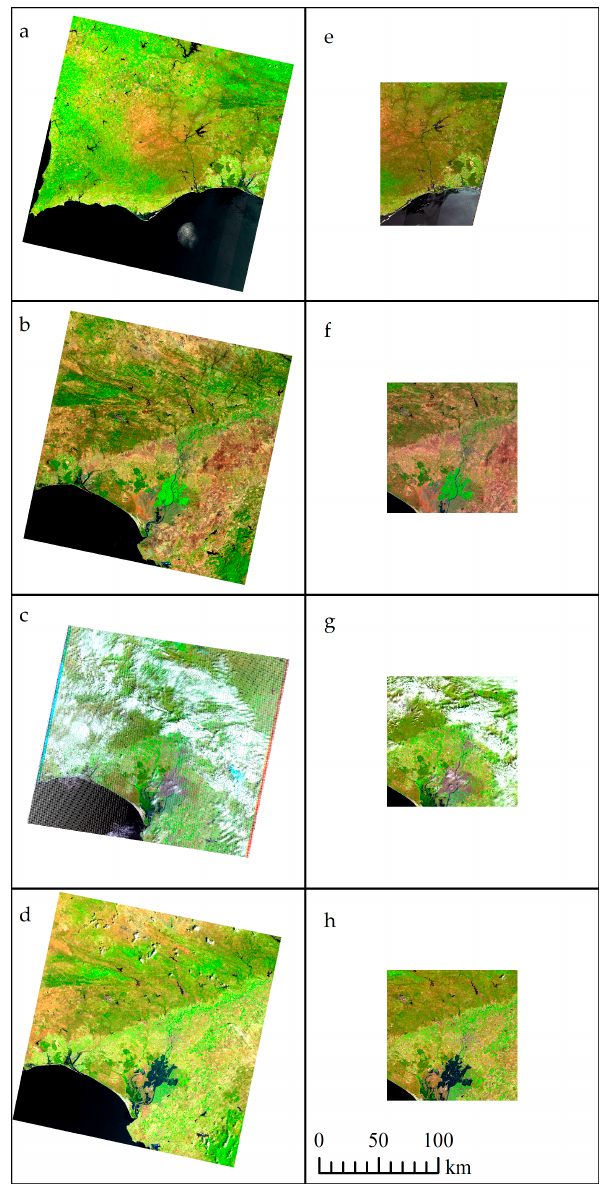
Figure 2. ( Left ) Landsat L1T images used. False color composite image (L7 RGB 543, L8 RGB 654); ( a )